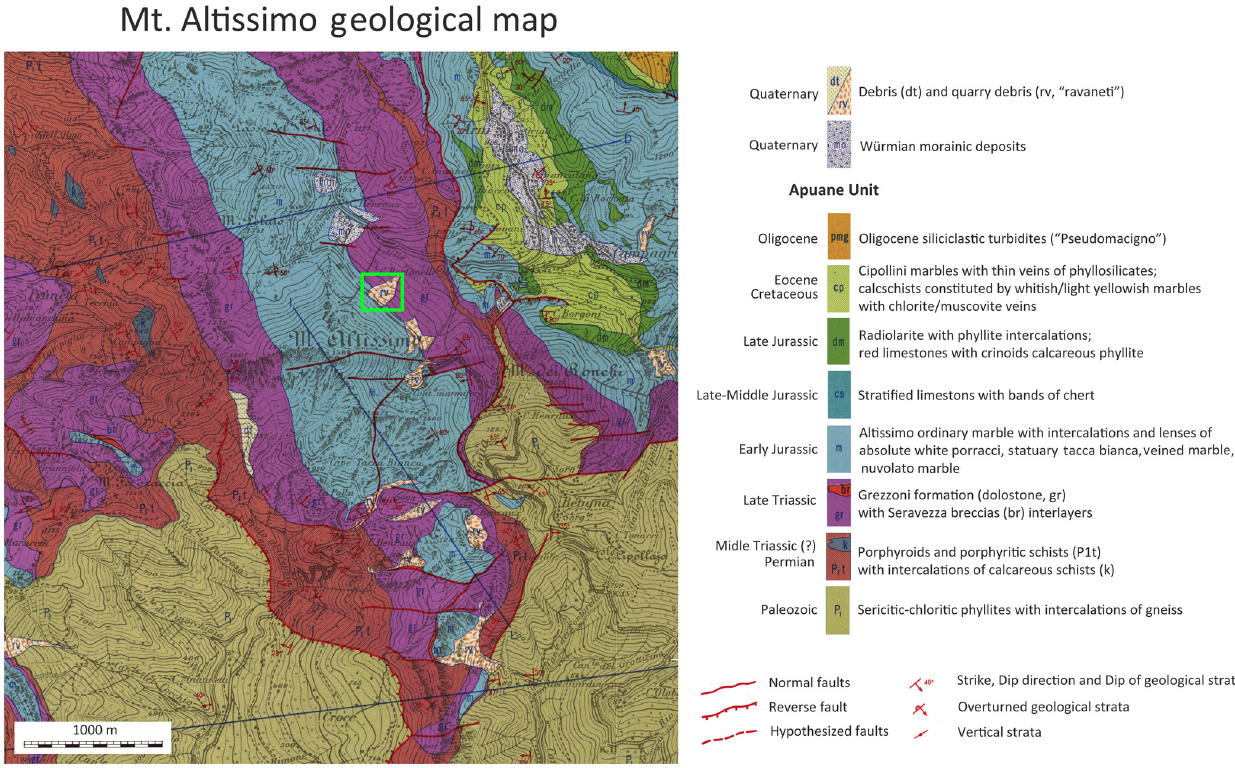
Figure 2. Geological map of the Mt. Altissimo area. The green rectangle indicates the location of the quarry (modified from Giglia and Paiotti, 1963). Table 1. Utilized RPAS and camera Table 1. Utilized RPAS and camera specifications.